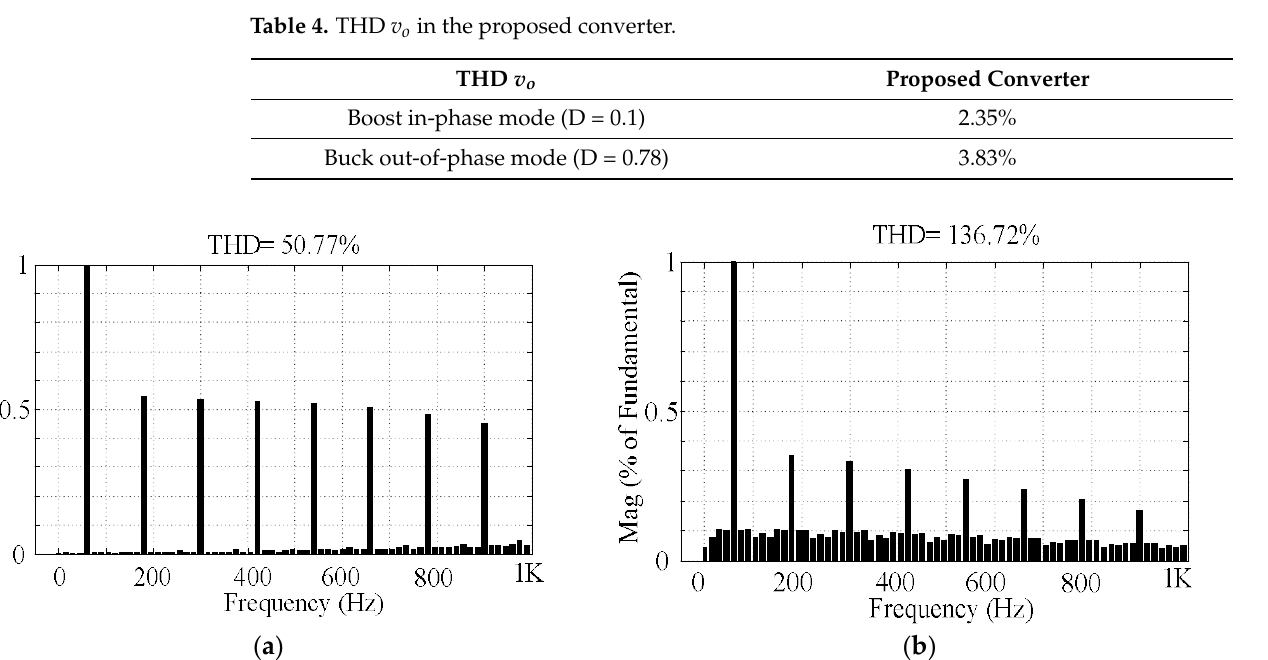
Figure 21. Simulation input current spectrums of the proposed topology in [18] for: ( a ) boost in-phase operating mode when D = 0.1, ( b ) buck out-of-phase operating mode when D = 0.78.